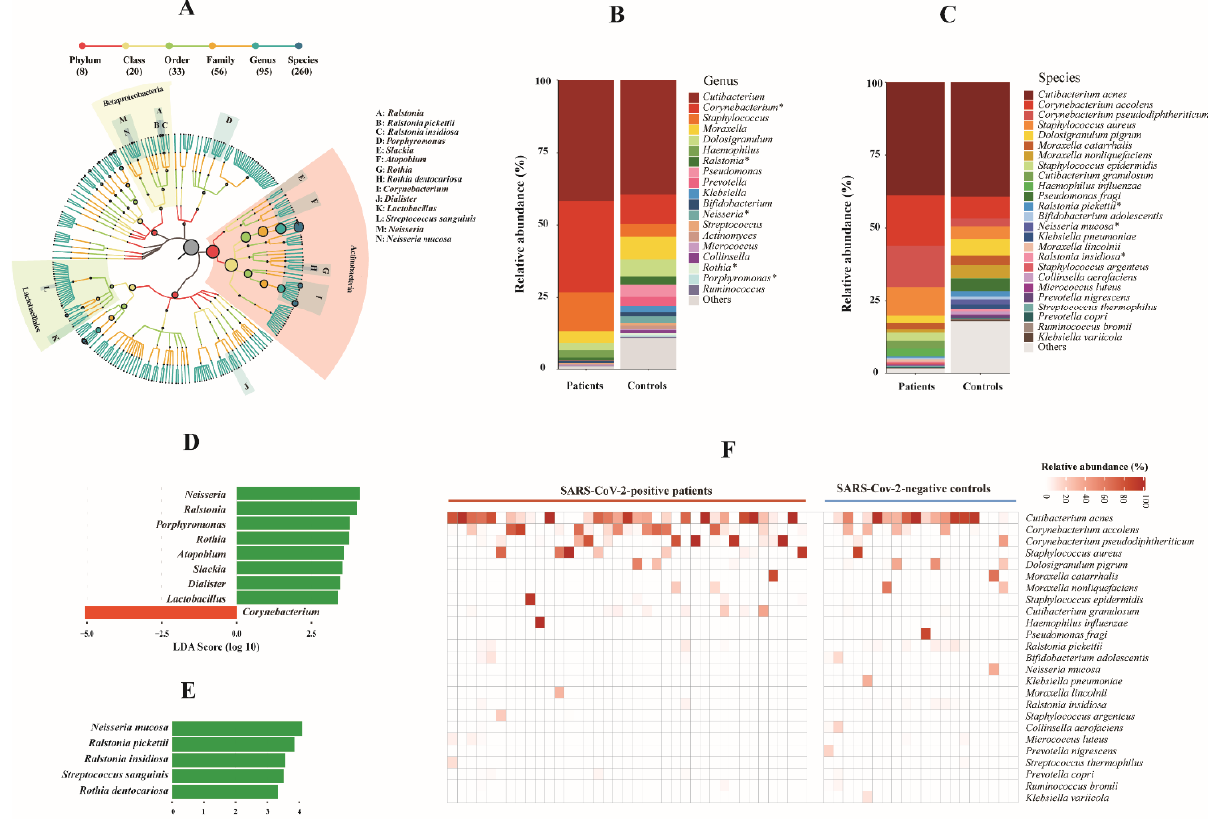
Figure 1. Bacterial microbiota composition in COVID-19 patients and SARS-CoV-2-negative controls. ( A ) Taxonomic tree of identified bacterial taxa. Each dot represents a taxonomic entity. The root of the tree denotes the domain bacteria. From the inner to outer circles, the taxonomic levels range from phylum to species. Different colors of dots indicate different taxonomic levels according to the color key shown. Numbers in parentheses indicate the total number of unique taxa at each taxonomic level. Significantly differentially abundant genera and species between COVID-19 patients and negative controls are labelled with A-N as indicated, more details are shown in Figure 1D,E. The size of each node represents their relative abundance. ( B , C ) Bar plots of main bacterial taxa at genus and species levels (average relative abundance > 0.2%) between patients and controls. * Statistically significant dif- ference (Benjamini – Hochberg adjusted p < 0.06). ( D , E ) Taxonomic biomarkers at genus ( D ) and species level ( E ) identified by linear discriminative analysis (LDA) effect size (LEfSe) analysis between patients (in red) and controls (in green). LDA scores (log 10) for the enriched taxa in controls are represented on the positive scale, while LDA-negative scores indicate enriched taxa in patients. The LEfSe alpha value was set at 0.05, and the threshold used to consider a discriminative feature for the LDA score was set at >2. ( F ) Heat map of abundant bacterial species (average abundance > 0.2%) among individ- uals between patients and controls. The relative abundance of bacterial species is represented by color gradient as indicated. The species were ordered by decreasing relative abundance. 3.3. Distinct URT Microbiota Diversity in COVID-19 Patients A significant reduction in alpha diversity of bacterial microbiota at genus level was found in NP samples from COVID-19 patients compared to those from SARS-CoV-2 neg- ative controls, as measured by the microbial richness (adjusted p = 0.045, Wilcoxon rank sum test), Shannon and Simpson diversity indices (adjusted p = 0.034, Wilcoxon rank sum test) (Figure 2A). Similarly, a decrease in microbial richness, Shannon and Simpson indi- ces of alpha diversity at species level was observed in COVID-19 patients (adjusted p < 0.1, Wilcoxon rank sum test) (Figure 2B). No significant difference in beta diversity of bac- terial microbiota was found between samples from patients and controls at genus or spe- cies level, as assessed with Bray – Curtis and weighted UniFrac dissimilarities (data not